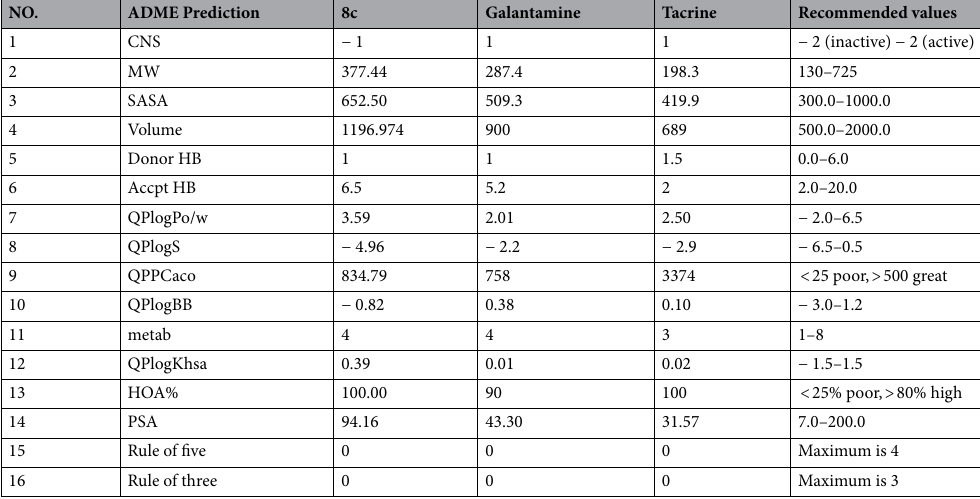
Table 2. ADME prediction results of inhibitor 8c , Galantamine , and Tacrine. CNS Predicted central nervous system activity, − 2 (inactive) − 2 (active), MW Molecular weight of the molecule, SASA Total solvent-accessible surface area, in square angstroms, using a probe with a 1.4 Å radius, Volume Total solvent- accessible volume, in cubic angstroms, using a probe with a 1.4 Å radius, Donor HB Estimated number of hydrogen bonds that would be donated by the solute, Accpt HB Estimated number of hydrogen bonds that would be accepted by the solute, QPlogPo/w Predicted octanol/water partition coefficient, QPlogS Predicted aqueous solubility. S in mol/dm 3 , is the concentration of the solute’s saturated solution that is in equilibrium with crystalline solid, QPPCaco Predicted apparent Caco-2 cell permeability in nm/s (a model for the gut– blood barrier), QPlogBB Predicted brain/blood partition coefficient, Metab Number of primary metabolites, QPlogKhsa Prediction of binding to human serum albumin, %HOA Predicted qualitative human oral absorption, PSA Van der Waal surface area of polar nitrogen and oxygen atoms, ROF Number of violations of Lipinski’s rule of five, molecular weight < 500, QPlogPo/w < 5 number of hydrogen bond donors ≤ 5, number of hydrogen bond acceptors HB ≤ 10, ROT Number of violations of Jorgensen’s rule of three (QPlogS > − 5.7, QPCaco > 22 nm/s, number of primary metabolites <